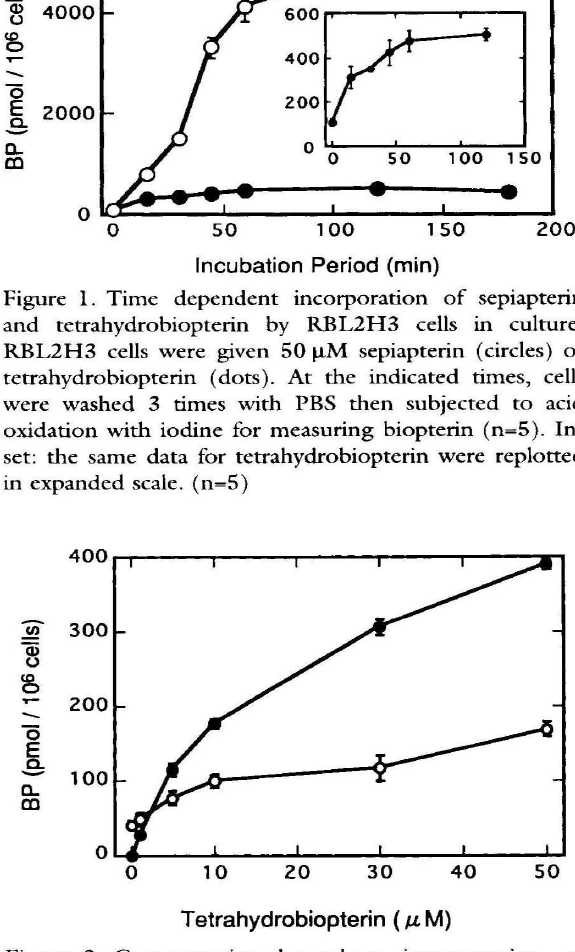
Figure 2. Concentration-dependent incorporation of tetrahydrobiopterin with DAHP-treated (dots) or non treated (circles) RBL2H3 cells: RBL2H3 cells were treat ed with or without 5 mM DAHP overnight. Cells were given tetrahydrobiopterin at concentrations indicated in the figure. Two hours later, cells were washed and acid oxidized, then the cellular biopterin was measured. (n=5)